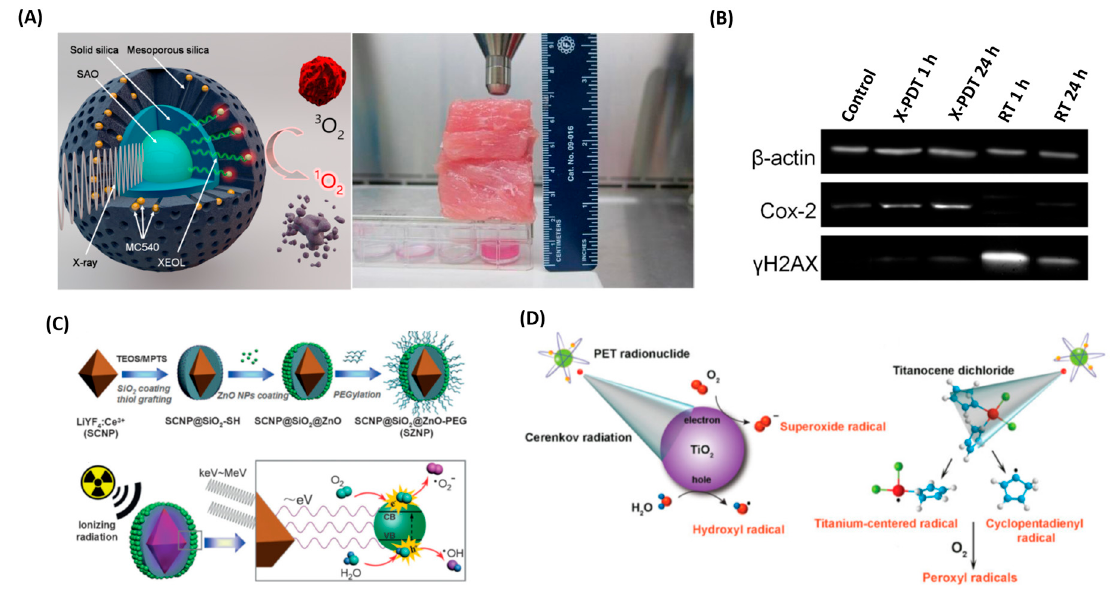
Figure 4. ( A ) Schematic illustration of the working mechanism of X-PDT. Under X-ray irradiation, SAO converts X-rays to visible light photons. The visible light photons, with 4.5 cm thick pork positioned between the X-ray source and cells, activate nearby MC540 molecules to produce cytotoxic 1 O 2 that destroys cancer cells in the proximity. Reprinted with permission from references [77]. ( B ) Western blot assays, which further confirm the impact of X-PDT on DNA and membrane lipids. Reprinted with permission from references [78]. ( C ) Schematic illustration of the synthetic route and the mechanism of ionizing radiation-induced PDT. The electron–hole (e − –h + ) pair is formed after exposure to ionizing radiation. Reprinted with permission from references [85]. ( D ) Schematic of CR-mediated excitation of TiO 2 NP to generate cytotoxic hydroxyl and superoxide radicals from water and dissolved oxygen, respectively. Reprinted with permission from references [33].